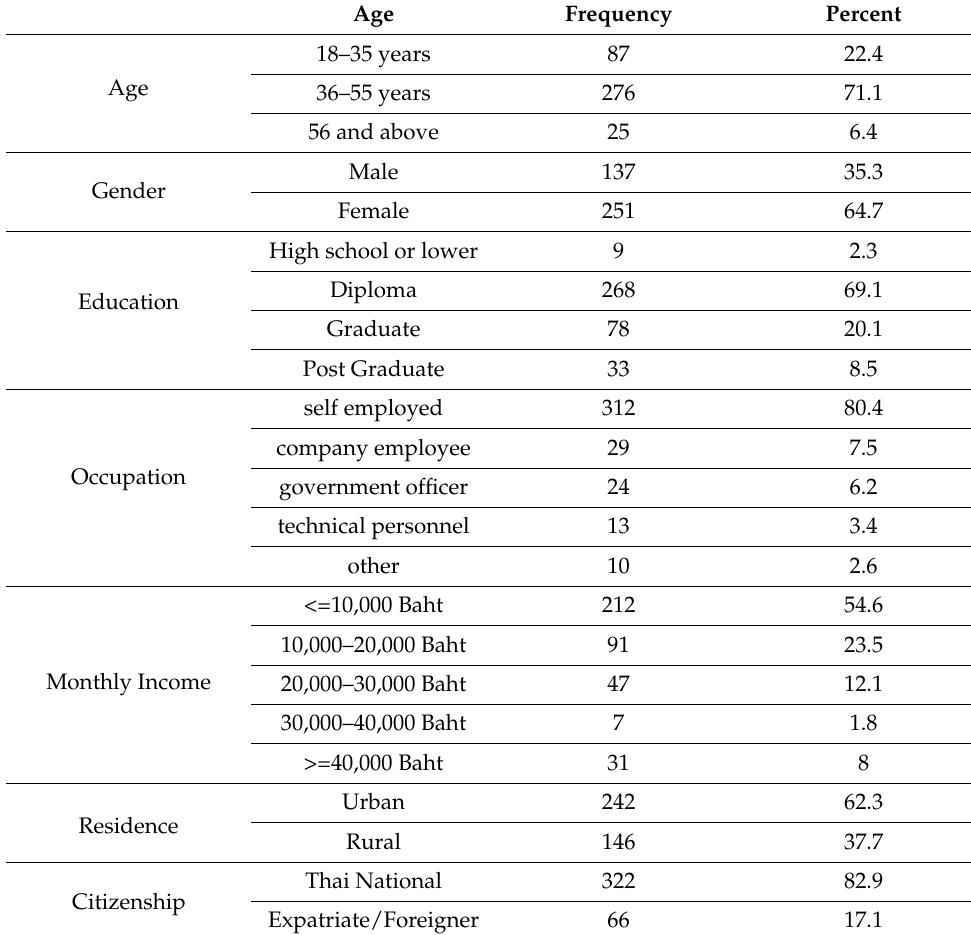
Table 1. Demographics of the Study